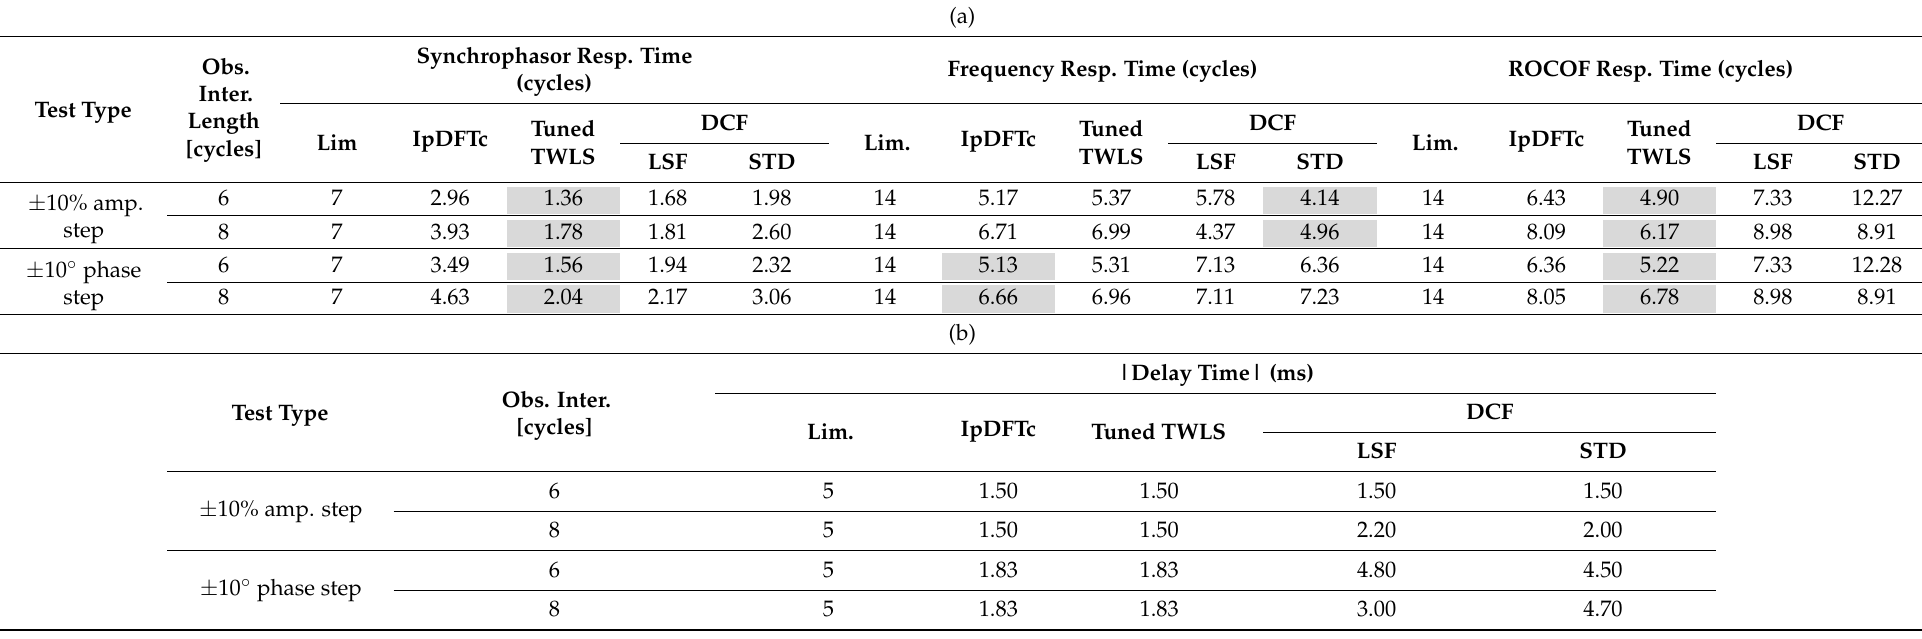
Table 7. Maximum response times (expressed in nominal power line cycles) associated with synchrophasor, frequency and ROCOF estimation (a) and maximum delay times (b), under